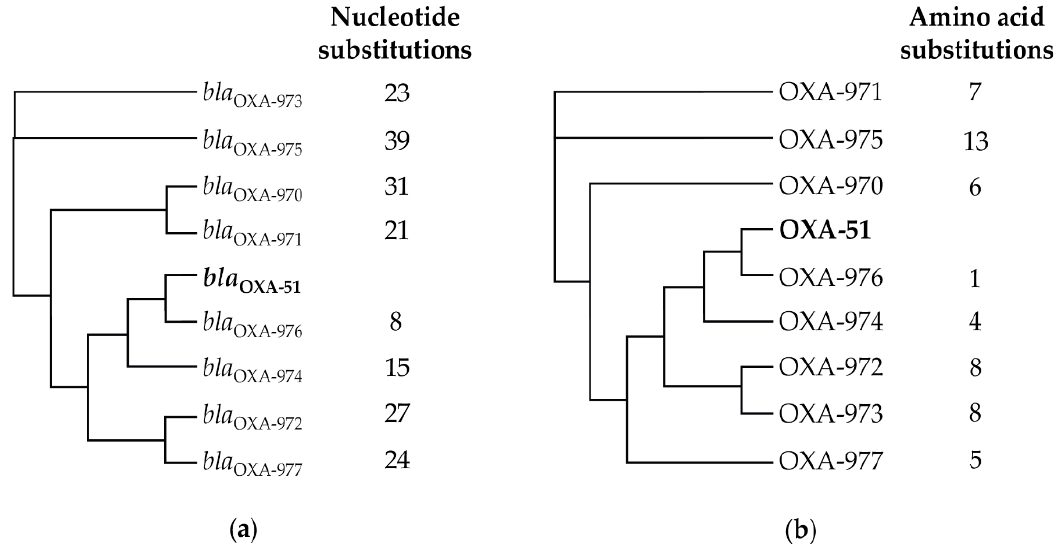
Figure 1. Neighbor-joining trees of the eight novel ( a ) bla OXA-51 -like variants in comparison to bla OXA-51 and ( b ) OXA-51-like variants in comparison to OXA-51 indicating the number of nucleotide and amino acid substitutions, respectively. Alignment trees were performed by using “Geneious Tree Builder” provided by Geneious 8.1.9 (Biomatters, Auckland, New Zealand). NCBI Reference Sequences for bla OXA-970 to bla OXA-977 : NG_077991.1 to NG_077998.1.